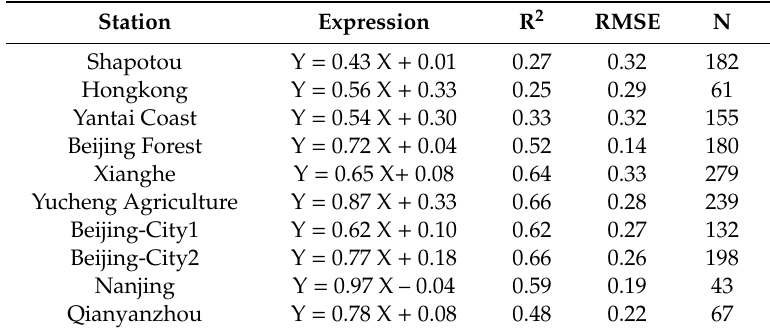
Table 3. The relationship between ground-measured and Visible Infrared Imaging Radiometer Suite Aerosol Optical Depth at each